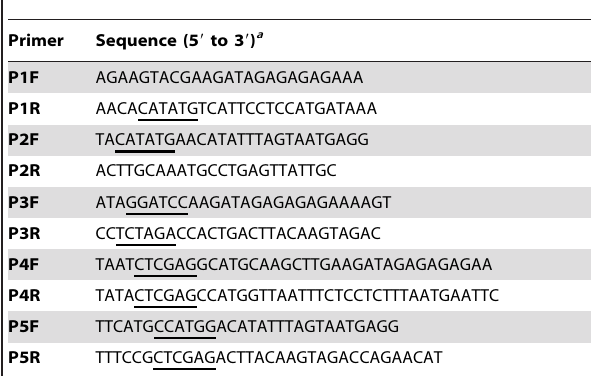
Table 1. Primers used in the study a